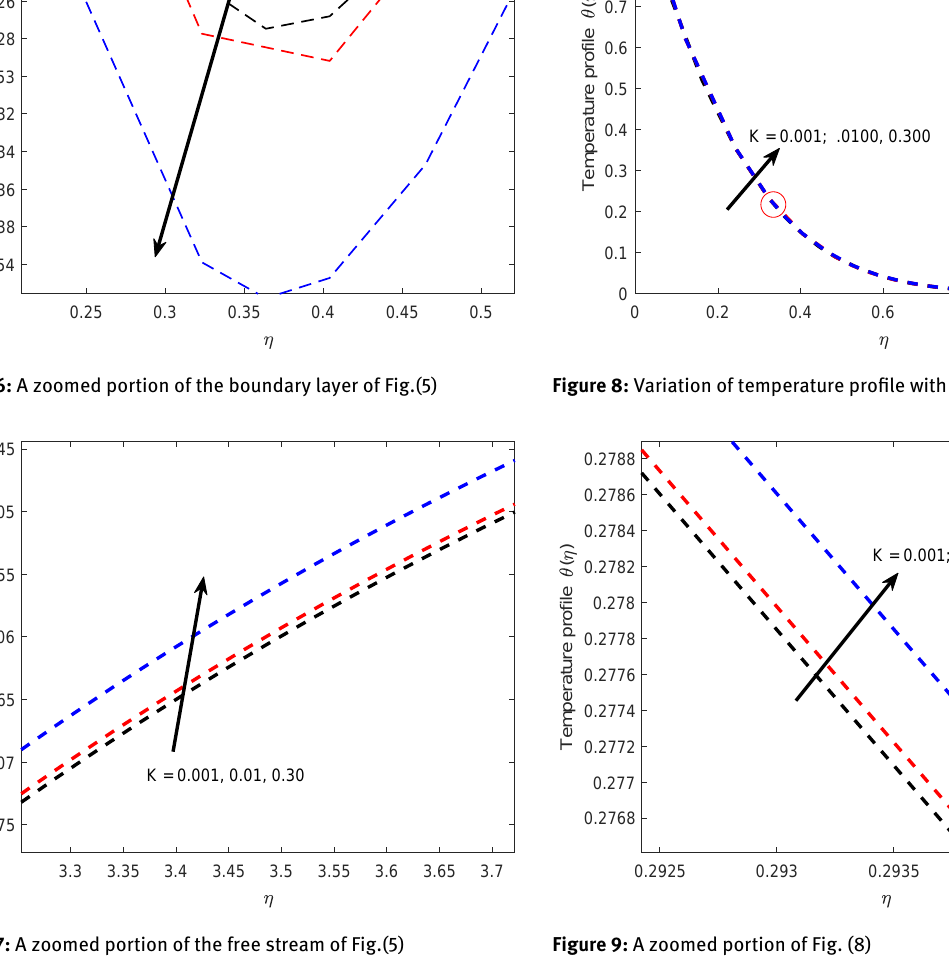
thermal diffusivity or increase in the momentum diffu- sivity. Consequently, as the Prandtl number increases, convection becomes more responsible for the transfer of energy than heat diffusion. The effects of Prandtl number was captured for Gr = 3, m = 0.3, χ = 0.25, β = 1.3.